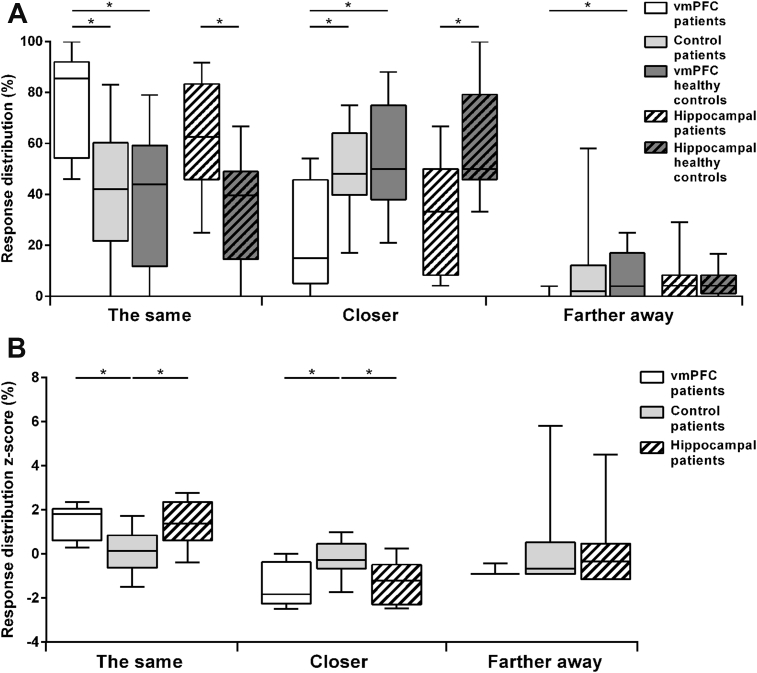
A: Box-plots of the percentage of trials classified as the same, closer-up and farther-away in the Rapid Serial Visual Presentation Task by participant group. The data and significance levels contrasting patients with hippocampal damage and their controls are from Mullally et al. (2012). B: Box-plots of z-scores for the same, closer-up, and farther-away responses for the three patient groups. Boxplots depict the median, first and third quartiles, and minimum and maximum (whiskers) of the data sets. *p < .05.